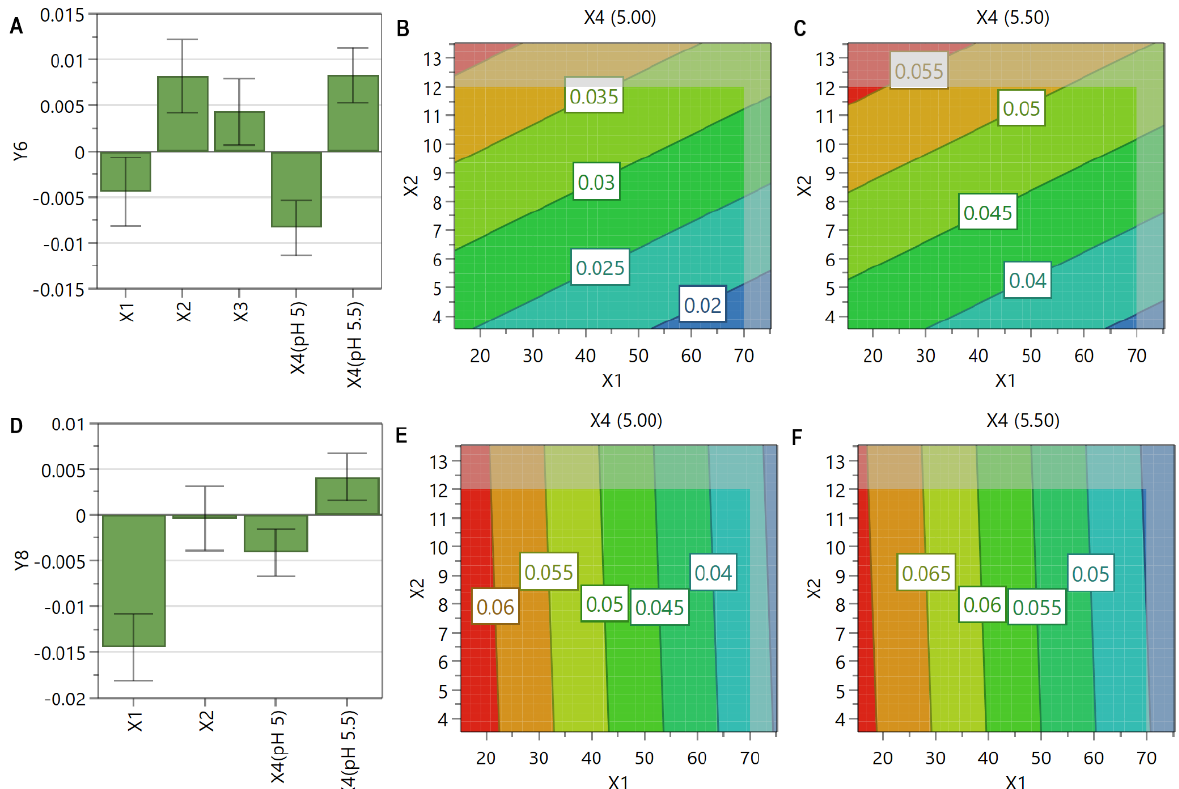
Figure 5. The coefficient plot ( A ) and the response contour plot for PdI before the incubation with DOX when the pH of the AS solution was 5.00 ( B ) or 5.50 ( C ). The coefficient plot ( D ) and the response contour plot for PdI after the incubation with DOX when the pH of the AS solution was 5.00 ( E ) or 5.50 ( F ). The coefficient plots evidence the significance of formulation factors in respect to these responses. The response contour plots evidence the variation of experimental results in respect to PL concentration (X1), SIM concentration (X2), and the pH of the AS solution (X4). X1: PL concentration (mM); X2: SIM concentration (mM); X3: DOX concentration (mM); X4: the pH of the AS solution; Y6: PdI before the incubation with DOX; Y8: PdI after the incubation with DOX.